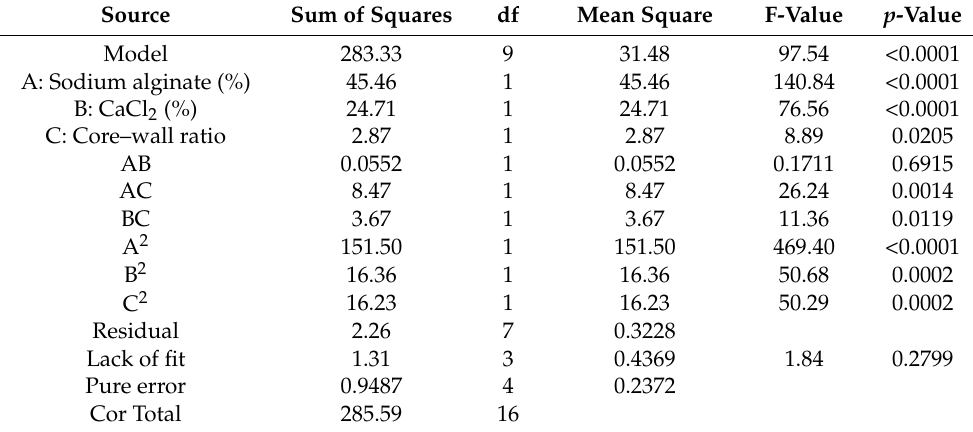
Table 3. Analysis of variance for determination of optimization model